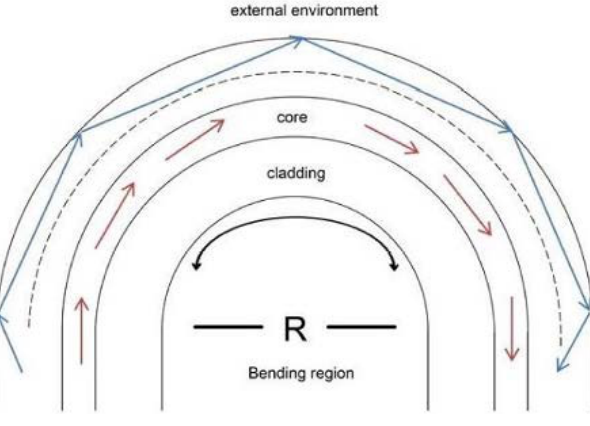
Figure 2. U-shaped fiber optic schematic diagram [23].